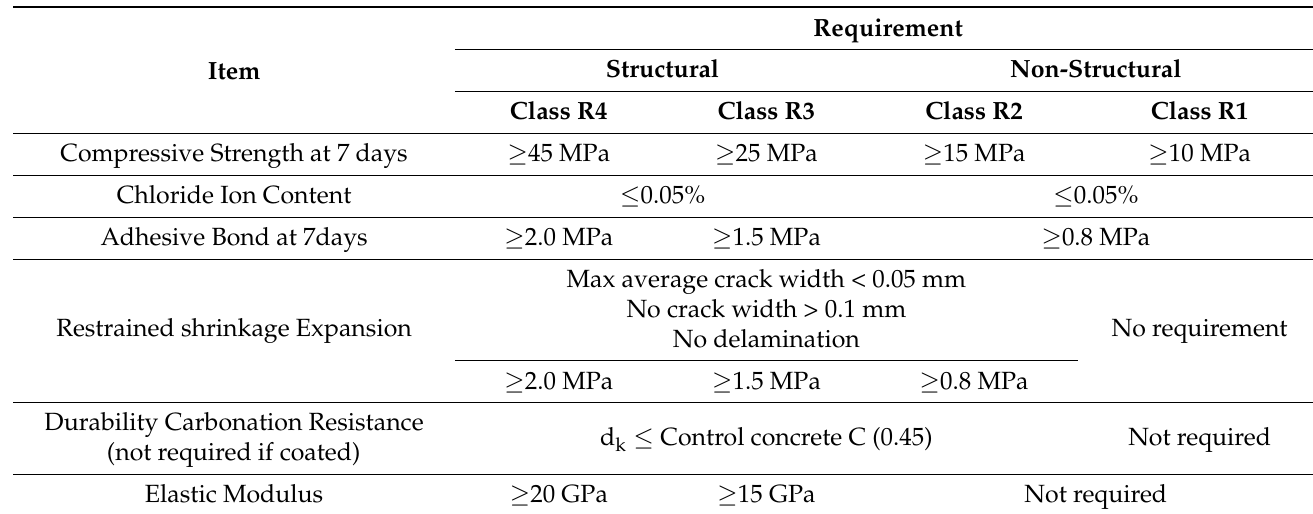
Table 2. European standard (EN1504-3) for performance requirements for cement-based structural and non-structural repair products [8].